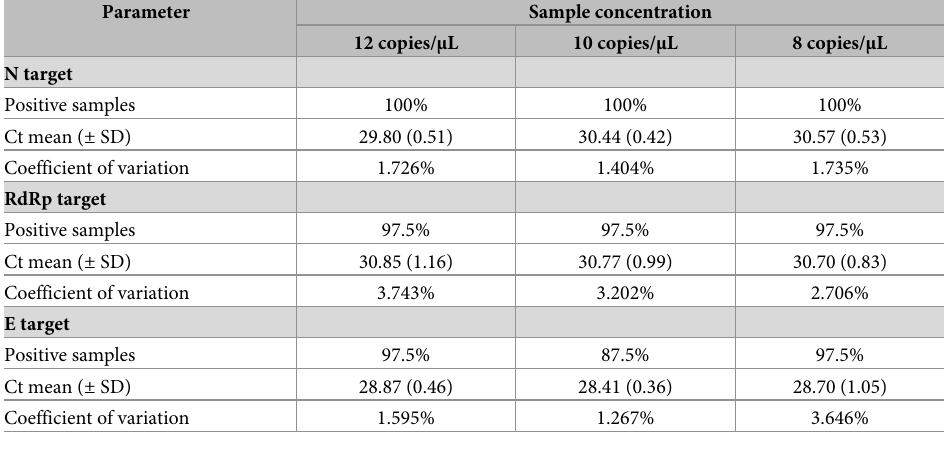
Table 2. Precision of HRM-RTqPCR assays targeting SARS-CoV-2 E, N and RdRp. SARS-CoV-2 templates were assayed in 40 technical replicates, at 12, 10 and 8 copies/ μ